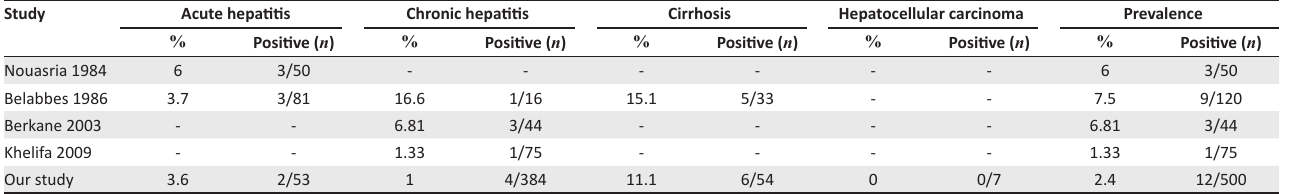
TABLE 5: Prevalence of viral hepatitis delta in Algeria.